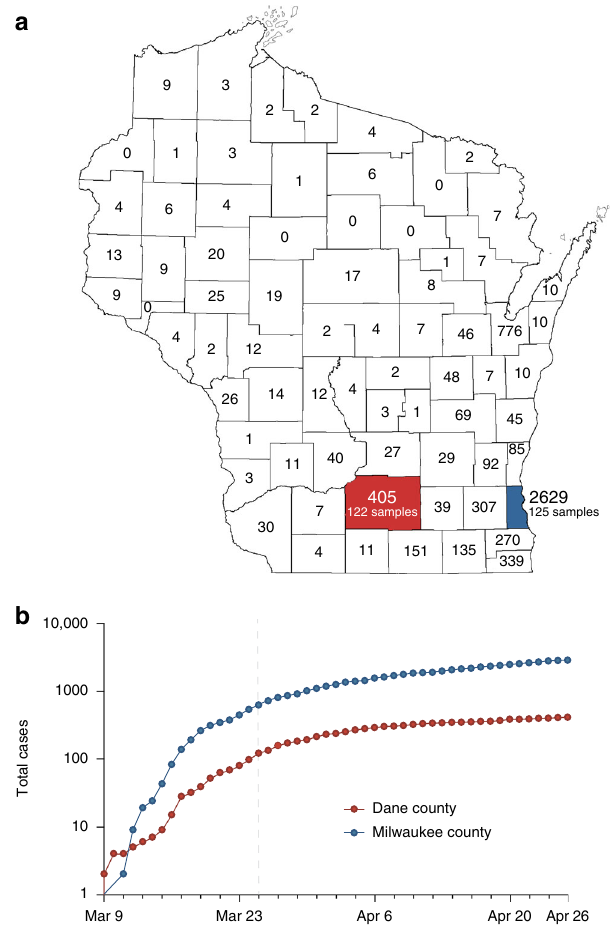
Fig. 1 Demography and epidemiology of SARS-CoV-2 in southern Wisconsin. a A map of Wisconsin highlighting Dane county (red) and Milwaukee county (blue). Cumulative case counts through 26 April 2020 are reported within each county border. The map of Wisconsin ’ s county borders was obtained with copyright permissions from the Wisconsin State Cartographer ’ s Of fi ce — https://www.sco.wisc.edu/maps/. b Cumulative SARS-CoV-2 cases in Dane county (red) and Milwaukee county (blue) from 9 March through 26 April. The vertical dashed line indicates the start date of Wisconsin ’ s “ Safer at Home ” order, which went into effect from 25 March 2020 24 . Source data to replicate this fi gure can be found in the Source Data fi